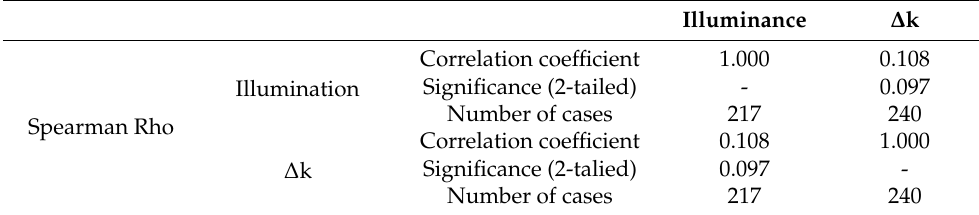
Table 5. Spearman correlation coefficient of illumination and ∆